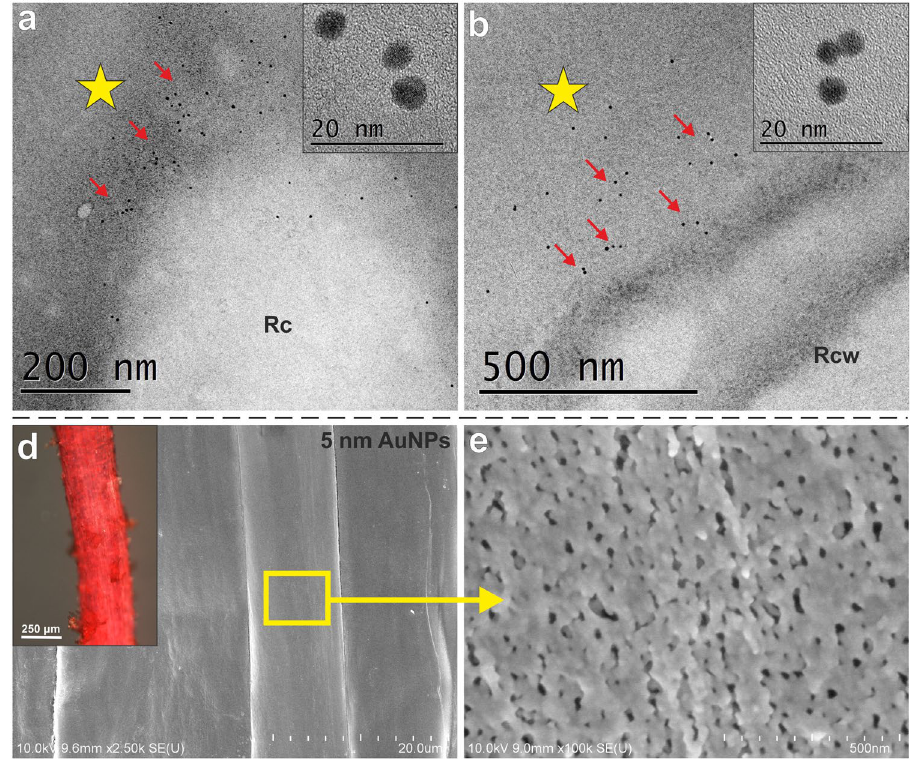
Figure 3. HRTEM and FE-SEM images of the rhizodermis of barley seedling roots grown in hydroponic conditions. Images obtained using the HRTEM ( a,b ) and FE-SEM ( c,d ) of barley roots grown in the 5 nm AuNPs solution (50 µ g/ml) ( a–d ). ( a ) Accumulation of AuNPs (red arrows) around the root cap cell. ( b ) Accumulation of AuNPs (red arrows) on the surface of the outer periclinal cell wall of the rhizodermis. Yellow asterisks indicate mucilage at the root surface. Inserts ( a,b ) in top right-hand corners show the high- resolution images of the selected AuNPs which confirm the characteristic for the gold crystal structure. ( c,d ) SEM micrographs showing the mucilage on the root surface. ( c ) Insert in the upper left-hand corner shows stereo microscope images of barley roots stained with neutral red to detect mucilage. Rcw – rhizodermal cell wall; Rc – root cap